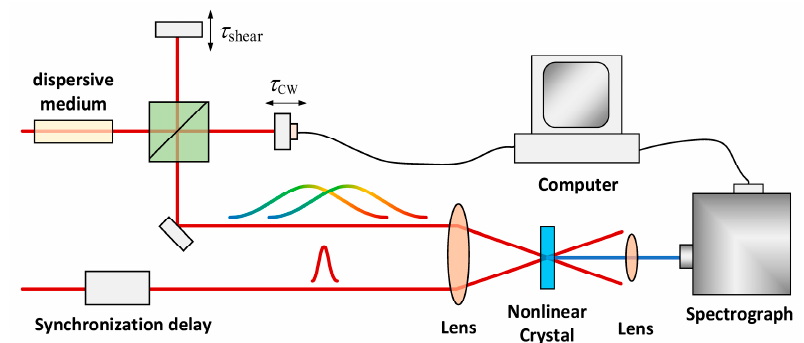
Figure 5. Schematic of 2DSI optics. The SPIDER is based on a collinear ZAP geometry, in the vertical arm of MI, a minor delay is introduced to generate time interferential